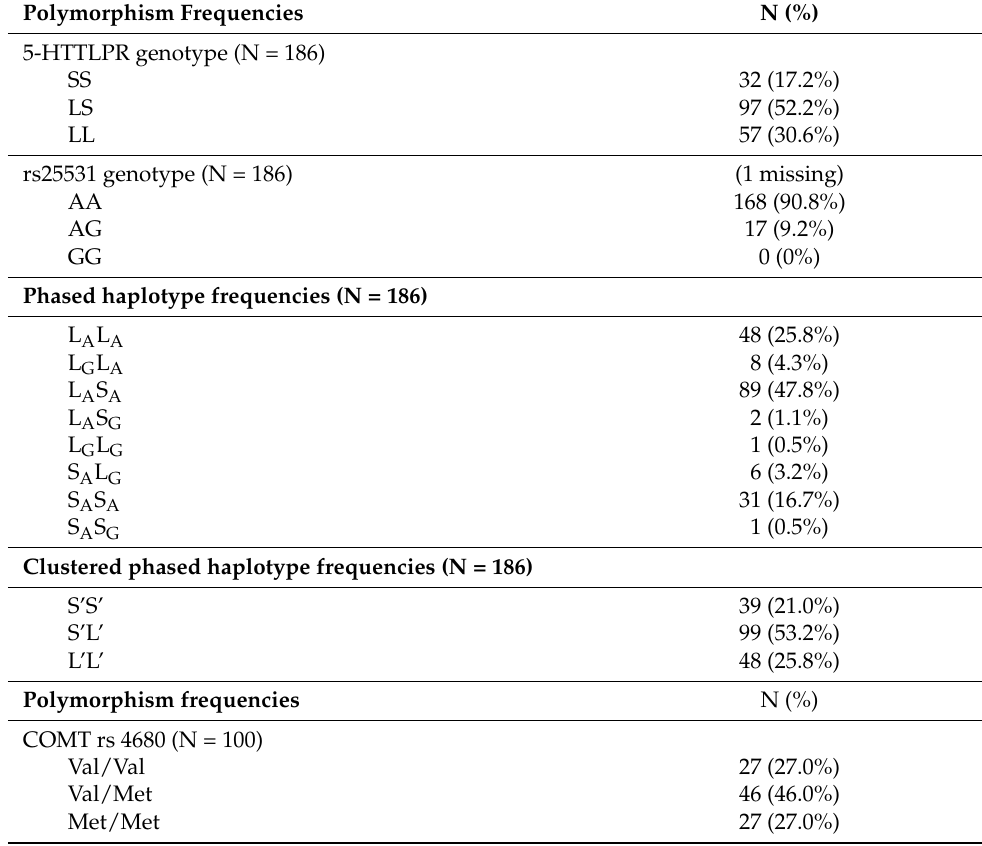
Table 2. Genotype frequencies, phased and clustered phased haplotype frequencies for 5-HTTLPR and rs25531 (N = 186), and genotype frequencies for COMT rs 4680 (N = 100).